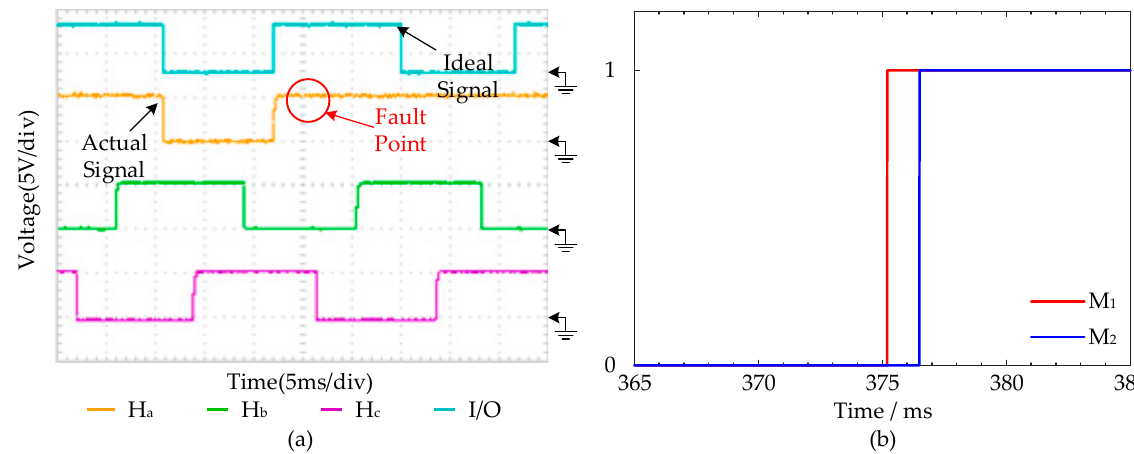
Figure 15. Hall Fault Type 3 diagnosis experimental results: ( a ) The Hall signal curves at Fault Type 3 and the ideal Hall signal curves. ( b ) The fault diagnosis experimental curves of M 1 and M 2 .